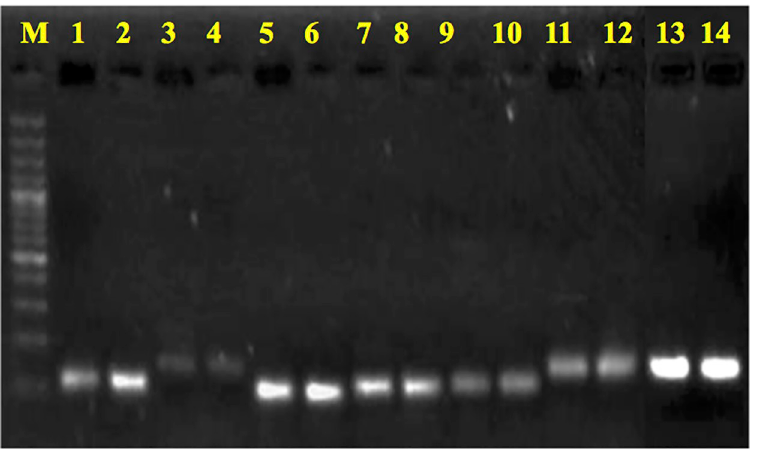
Fig 1. Confirmation of expected amplicon size for each primer pair. 2% agarose gel electrophoresis showing amplicon of a single product of expected size in both the genotypes for each reference gene. From left to right: M– 100 bp ladder, 1- ACT7 ( B . Juncea ), 2- ACT7 ( C . sativa ),3- CAC ( B . juncea ), 4- CAC ( C . sativa ), 5- EF1A ( B . juncea ), 6- EF1A ( C . sativa ), 7- PP2A ( B . juncea ), 8- PP2A ( C . sativa ), 9- TIPS41 ( B . juncea ), 10- TIPS41 ( C . sativa ), 11- TUA ( B . juncea ), 12- TUA ( C . sativa ), 13- UBQ9 ( B . juncea ), 14- UBQ9 ( C . sativa